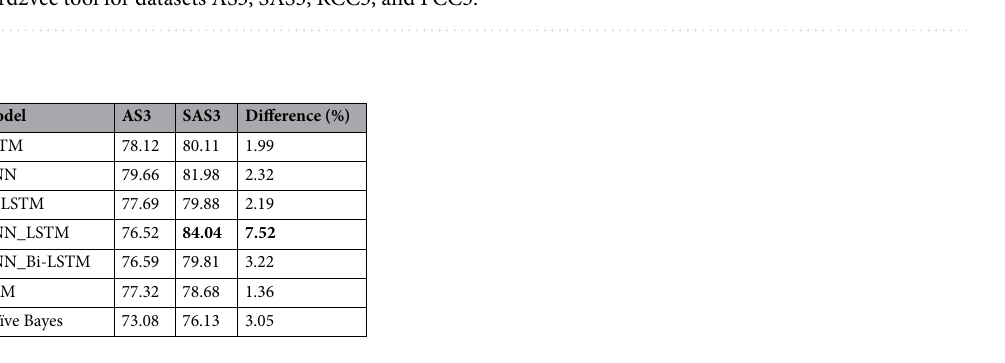
Table 5. Accuracy (%) of the algorithms when trained with the AS3 and SAS3 datasets. Significant values are in bold.